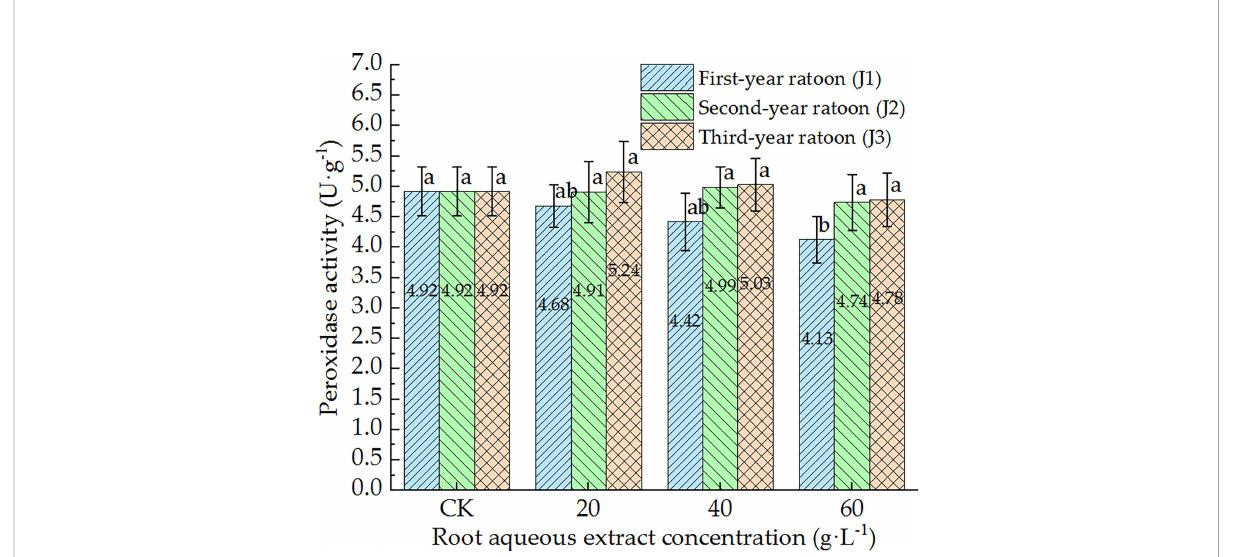
FIGURE 5 Response of POD activity in the culture medium of sugarcane seedlings to different root aqueous extracts. Different lowercase letters represent signi fi cant differences at the 5% level between different concentrations of root aqueous extract with the same ratoon